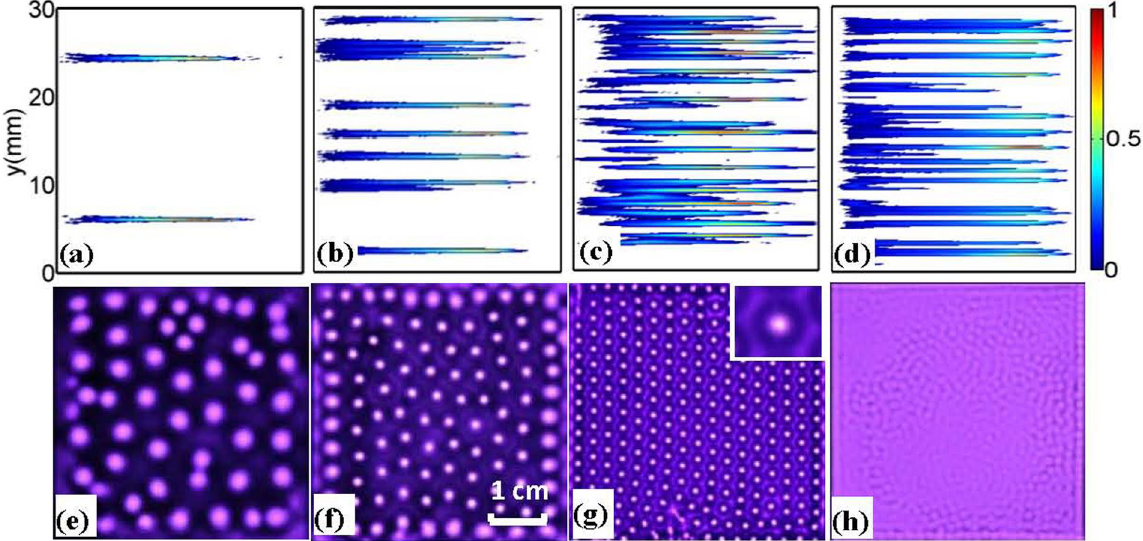
Figure 7. Transition of different patterns with voltage increasing. The top panel (a–d) displays the electron density distributions of the discharge in simulation, with the voltages U = 600 V, 870 V, 1200 V, 2500 V, respectively. Roughly, they are equivalent to the luminous filaments as usually observed in experiments. For simplicity, a normalized color bar is used here with the units: ( a ) 1.5 × 10 18 m − 3 , ( b ) 8.0 × 10 18 m − 3 , ( c ) 2.0 × 10 19 m − 3 , ( d ) 1.1 × 10 20 m − 3 . The bottom panel gives the experimental results: ( e ) Filaments with random arrangement, U = 1.6 kV; ( f ) Quasi-hexagon pattern, U = 1.8 kV; ( g ) Honeycomb superlattice, U = 2.2 kV, where one unit cell of the structure is magnified in the inset at the top-right corner; ( h ) Disordered state U = 3.6 kV. Experimental parameters: discharge gap d = 1.4 mm, voltage frequency f = 56 kHz, and exposure time t = 25 ms. The size of the discharge area is 45 × 45 mm. The experiment is performed in a mixture of He (80%) and air (20%) with gas pressure p = 200